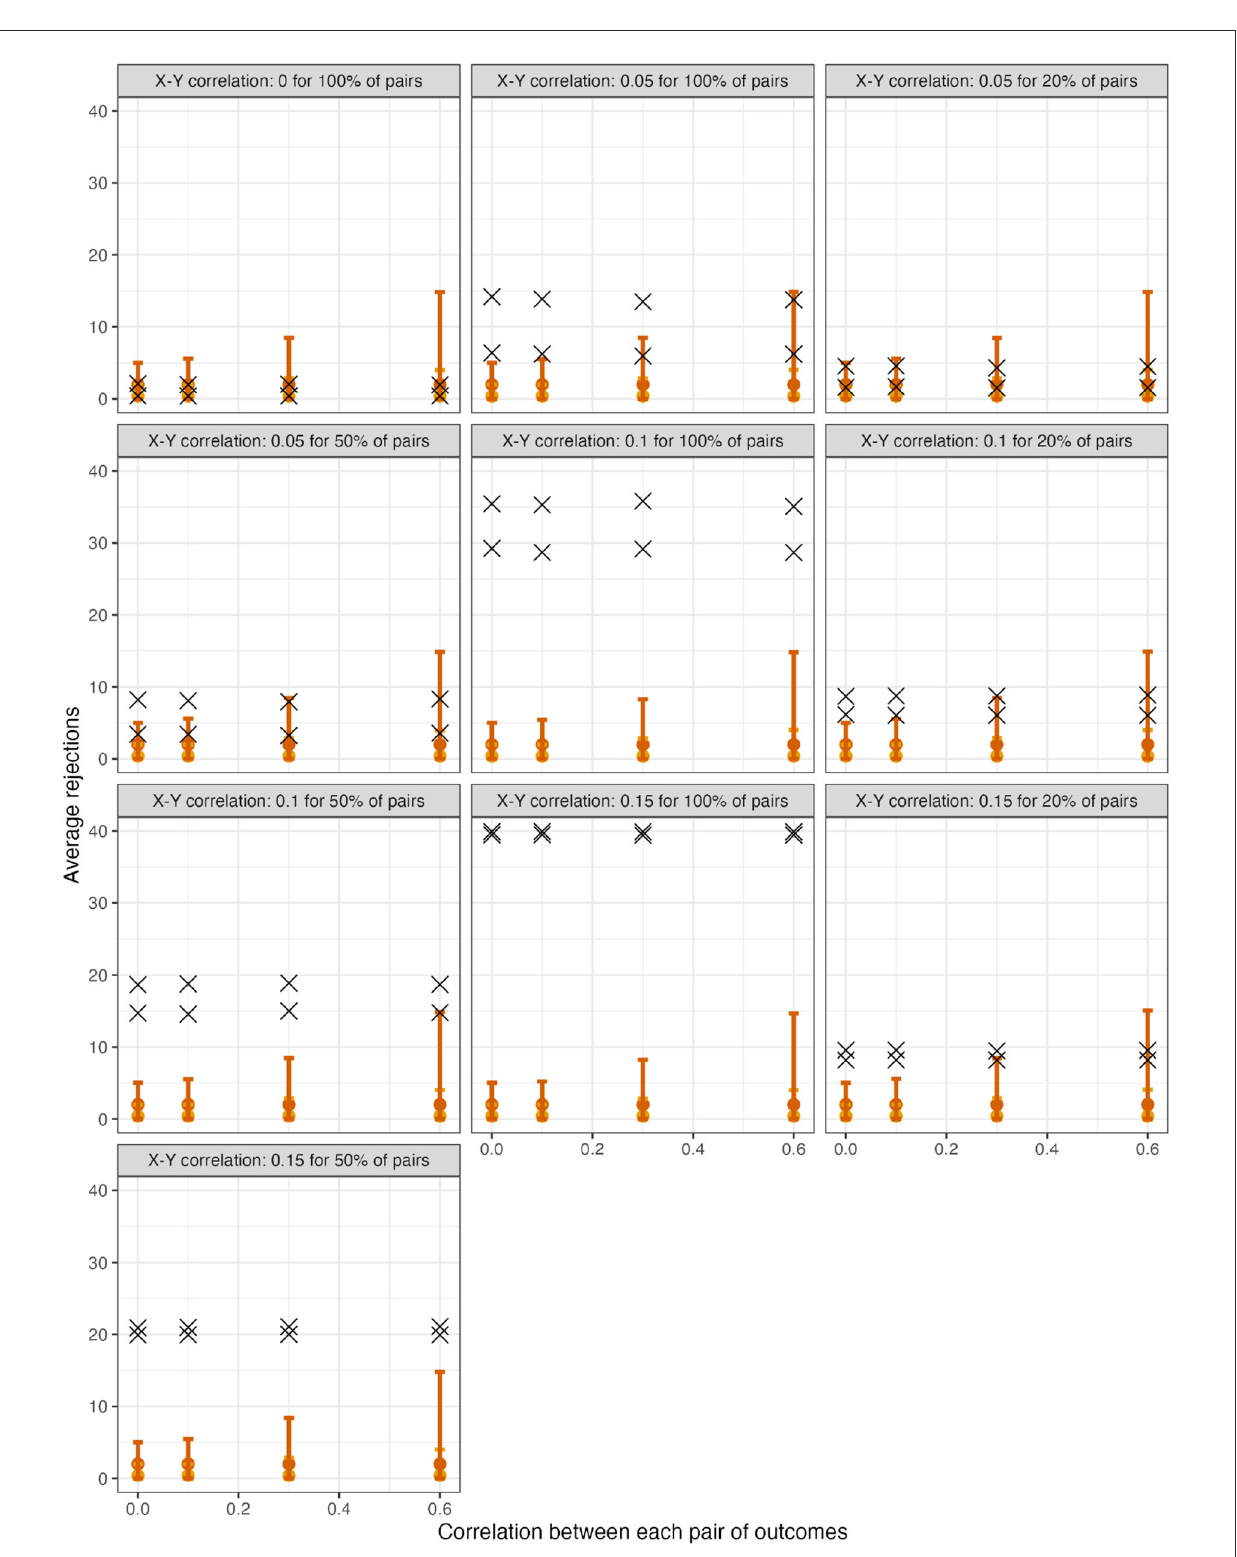
FIGURE1 For scenarios with 40 outcomes, 95% null intervals vs. mean rejections in observed datasets ( × ). Panels: Null and alternative data-generating mechanisms of original samples. Points and error bars: Mean ˆ θ ( j ) and mean limits of null intervals with tests at α = 0.01 (yellow) or at α = 0.05